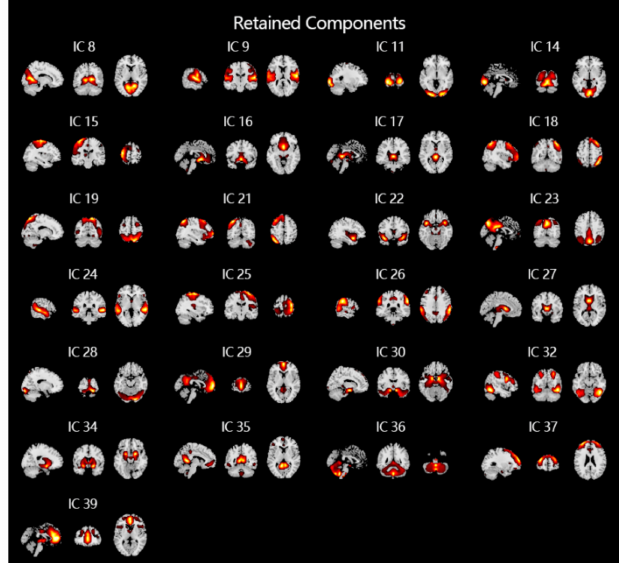
Figure 3. The results of ICA of fMRI and removal of noise and artifacts. After performing ICA, a total of 39 independent components that do not overlap in space are obtained. After manually removing 14 noises and artifacts, the 25 independent components shown in the figure are finally obtained and used as input to the